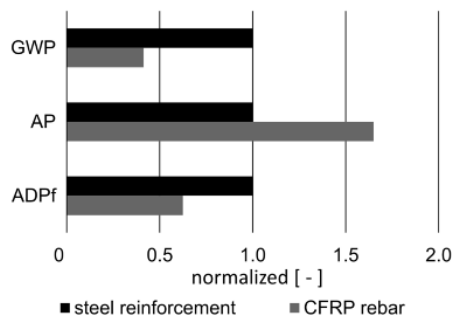
Figure 5. Comparison of steel and CFRP reinforce- ment per kg product system (normalized values).